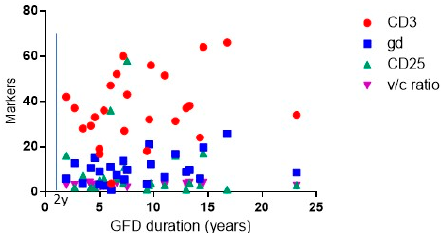
Figure 4. Linear correlation among different immunohistochemical markers and gluten free diet duration. Red circle represents CD3+ cells; blue squares TCR γδ + cells, green up-pointed triangles CD25+ cells, violet down-pointed triangles villous/crypts ratio. Vertical blue line represents the minimum period of gluten free diet (2 years). GFD: gluten free diet.